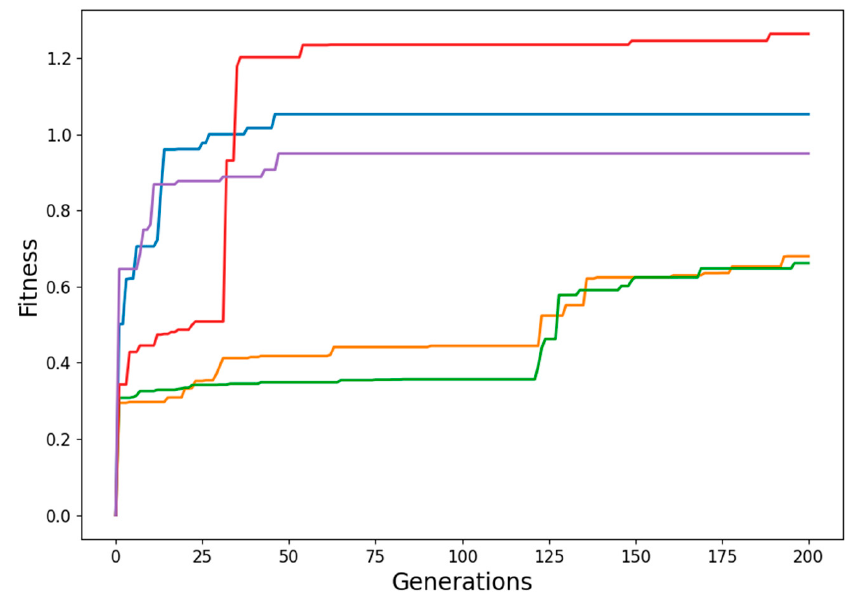
Figure 6. Adjacent joint reverse symmetry fitness for 5 simulation runs, showing that the majority of the robots reached a high fitness value. the robots reached a high fitness